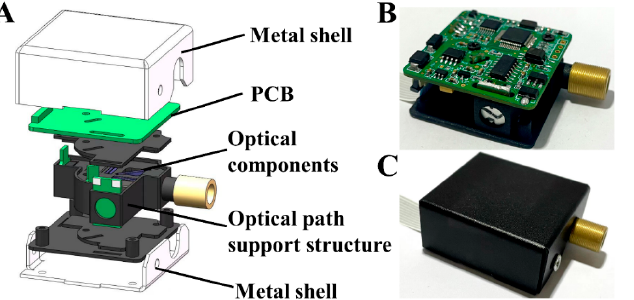
Figure 2. Structure and assembly of the fluorescence detector: ( A ) an exploded view of the three- dimensional (3D) structure; ( B ) a photo of the internal structure of the detector; ( C ) a photo of the detector with the metal box.